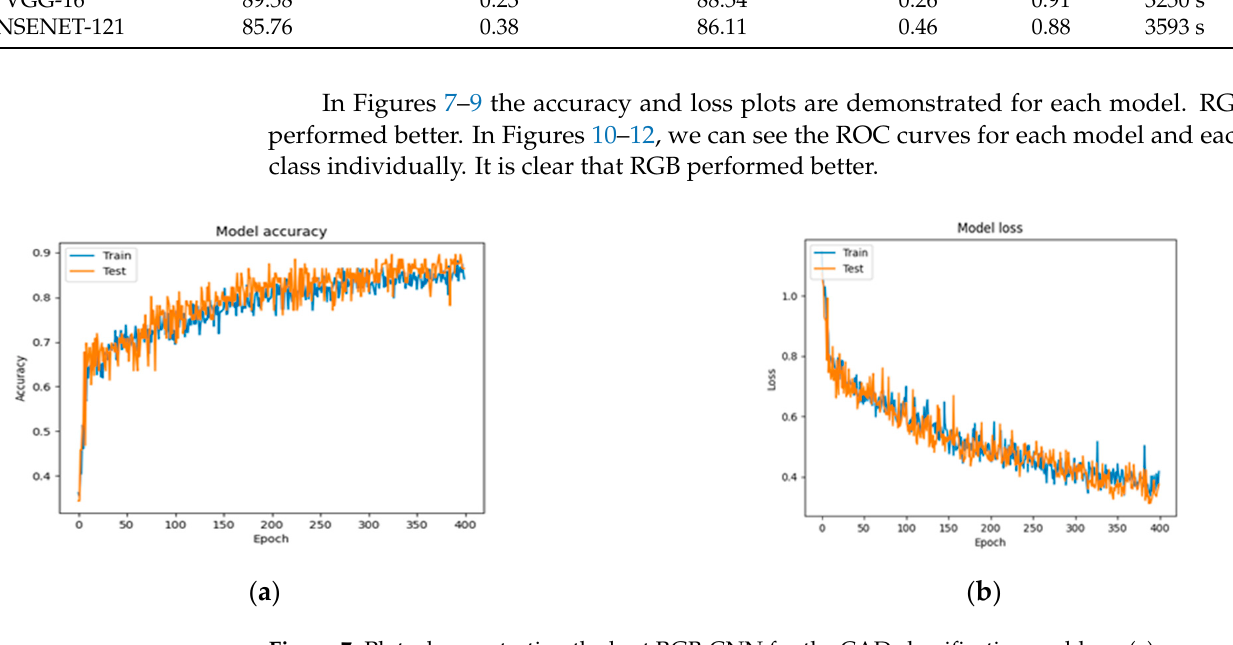
Table 5. Comparison of efficient metrics, between RGB and Transfer Learning Methods. Validation Accuracy DENSENET-121